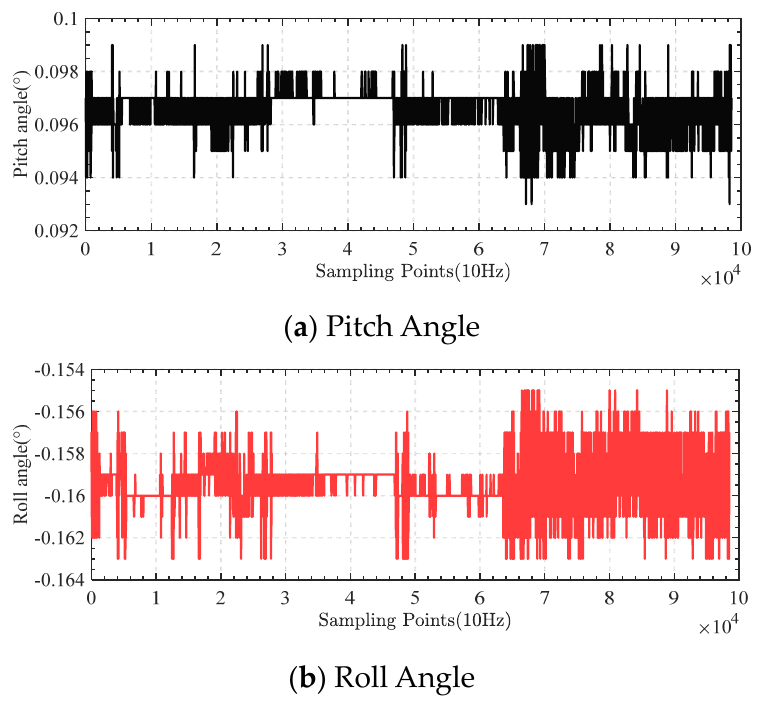
Figure 23. Ship-borne test results.